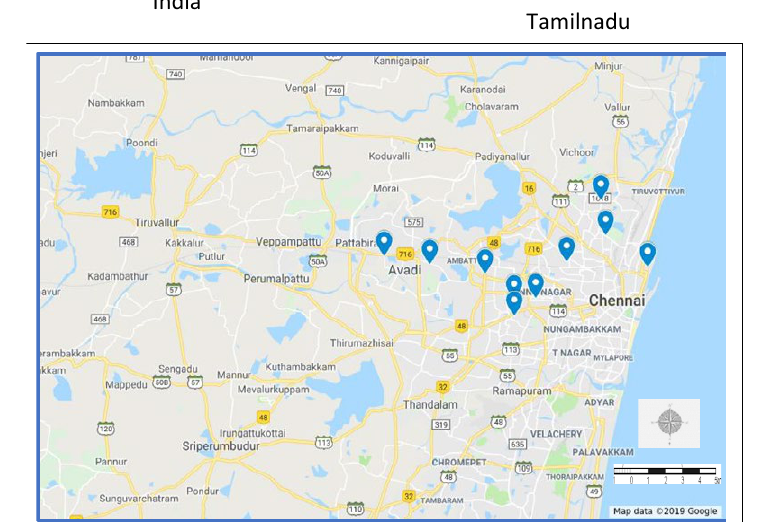
Fig. 2: Study Area Map Showing the location of Air Quality Monitoring